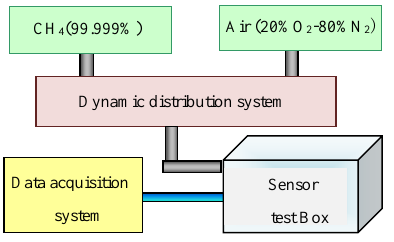
Figure 3. Dynamic gas testing system.